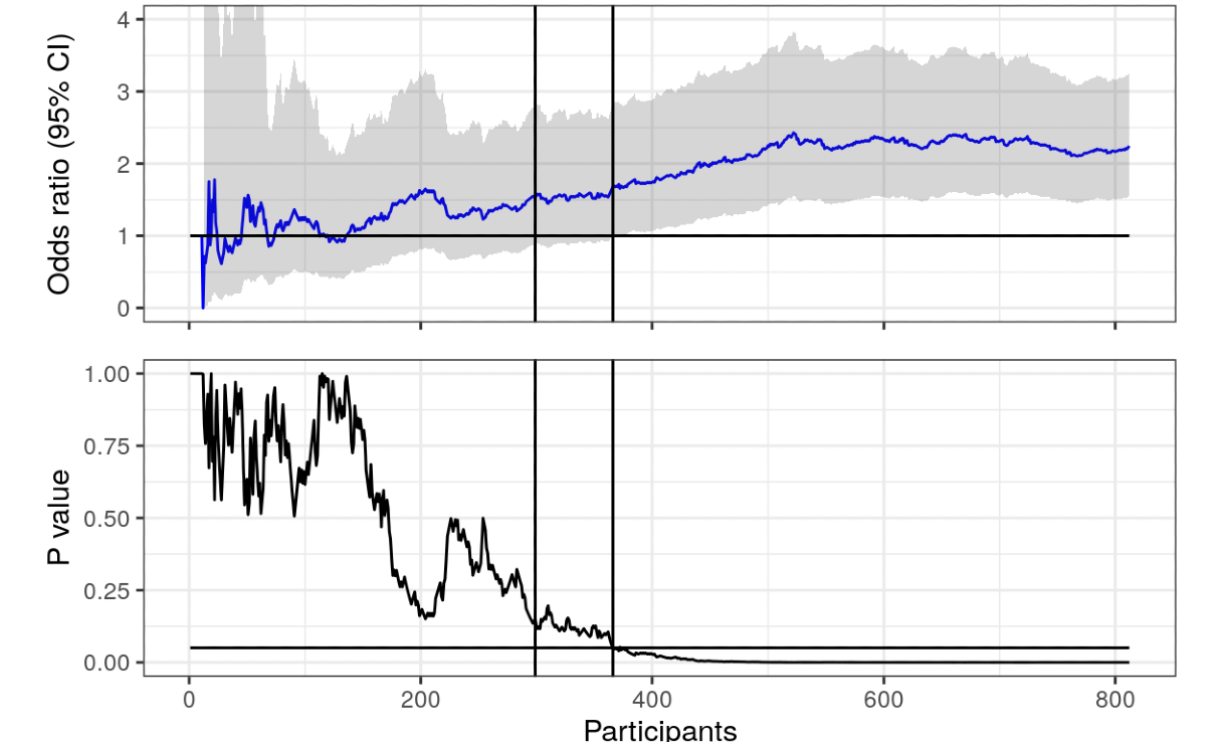
Figure 4. Point prevalence (with sampled data): odds ratios and P values calculated using actual and sampled data from trial, plotted over time (number of responders in the study). Horizontal lines represent null value (OR 1) and the .05 statistical significance line. First vertical line represents where the first 6 months of recruitment ended, second vertical line represents when point prevalence became statistically